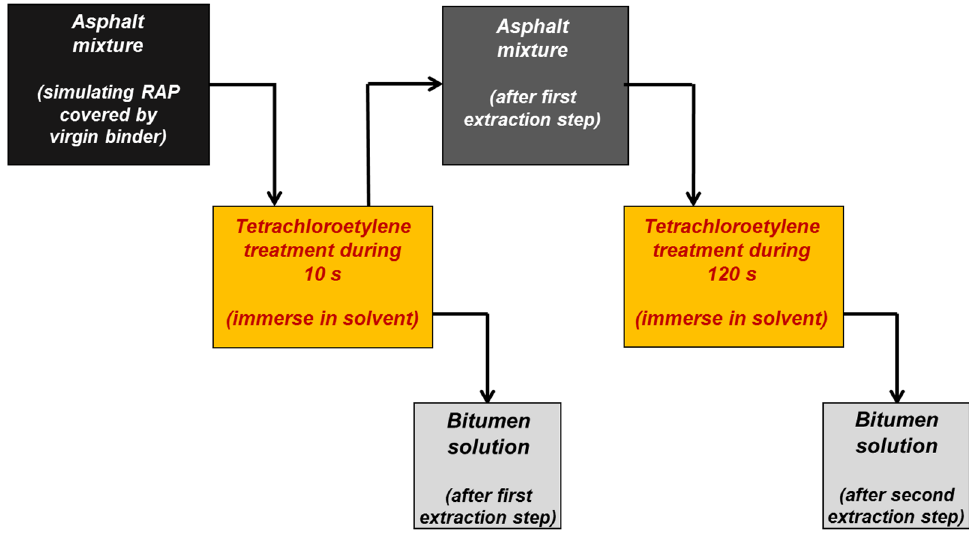
Figure 2. Scheme of the step extraction method.